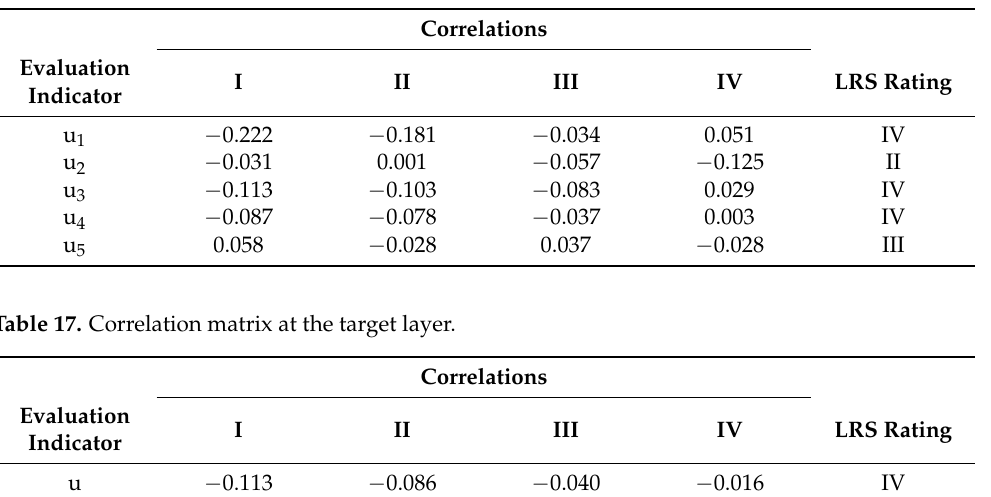
Table 16. Correlation matrix of each factor category at the criteria layer.